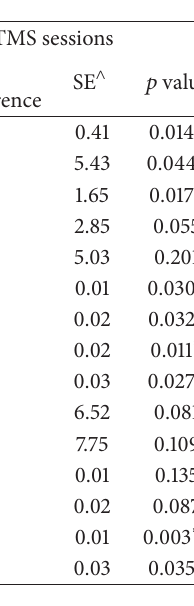
Table 1: Gait parameters scores before and after 1 rTMS session and 3 consecutive daily rTMS